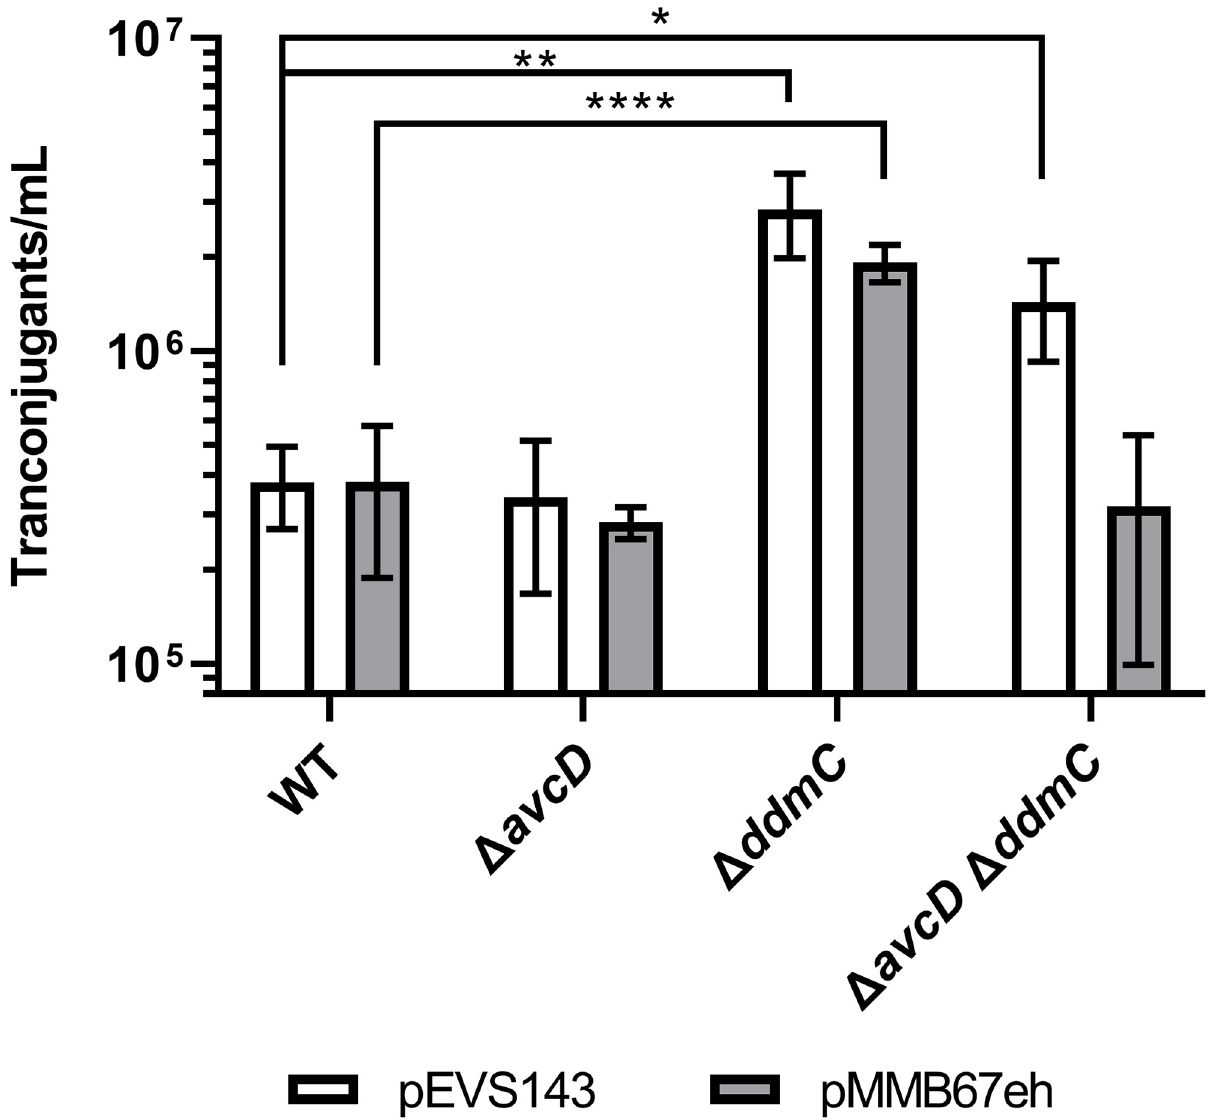
Fig 4. DdmC reduces plasmid conjugation. E . coli donors carrying either pEVS143(white bars) or pMMB67eh (grey bars) were mixed with different V . cholerae recipients as indicated and incubated together for 2.5 hours. Cells were then resuspended and an aliquot was plated on LB containing polymyxin B which is lethal to E . coli and either kanamycin (for pEVS143) or ampicillin (for pMMB67eh) and incubated overnight before the resultant colonies were counted. Significance was determined by Unpaired T tests with Welch’s correction with significance shown as � p < 0.0332 and �� p < 0.0021 ���� p < 0.0001.